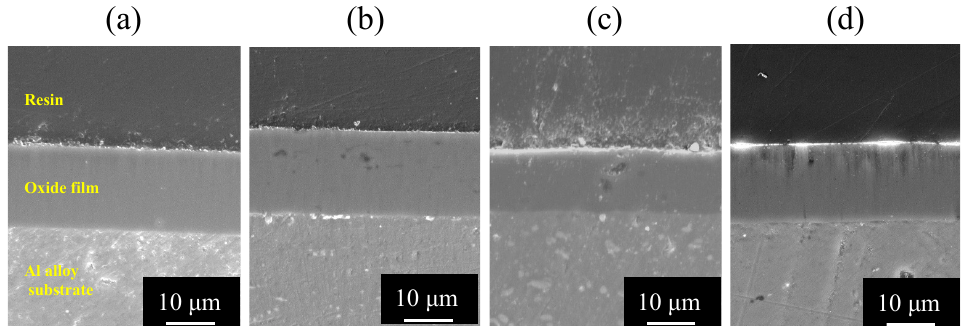
Figure 6. SEM images of the vertical cross section of ( a ) pure Al, ( b ) 1050-al alloy, ( c ) 3003-Al alloy, and ( d ) 5052-Al alloy specimens after anodizing for t a = 1800 s. Anodizing conditions are described in Figure 3.